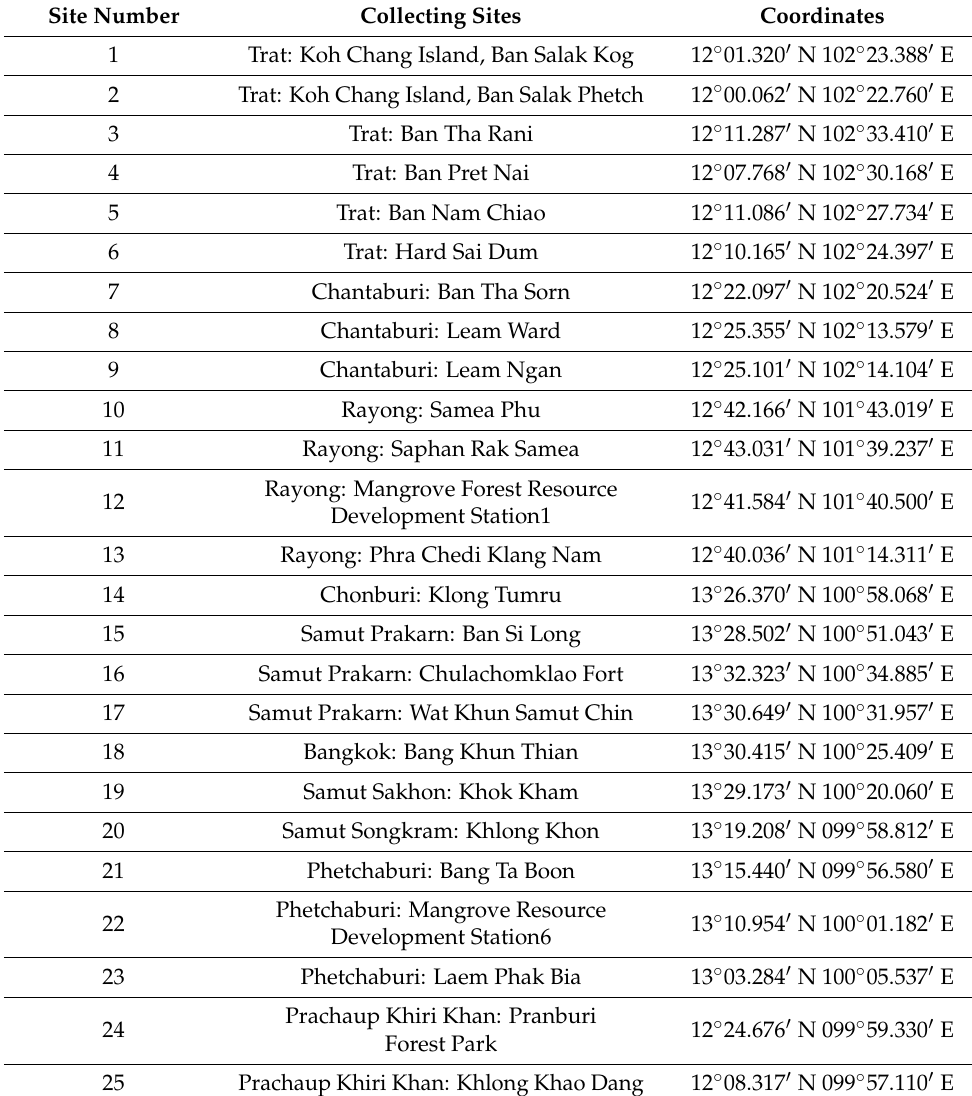
Table 1. Collection data of samples in this